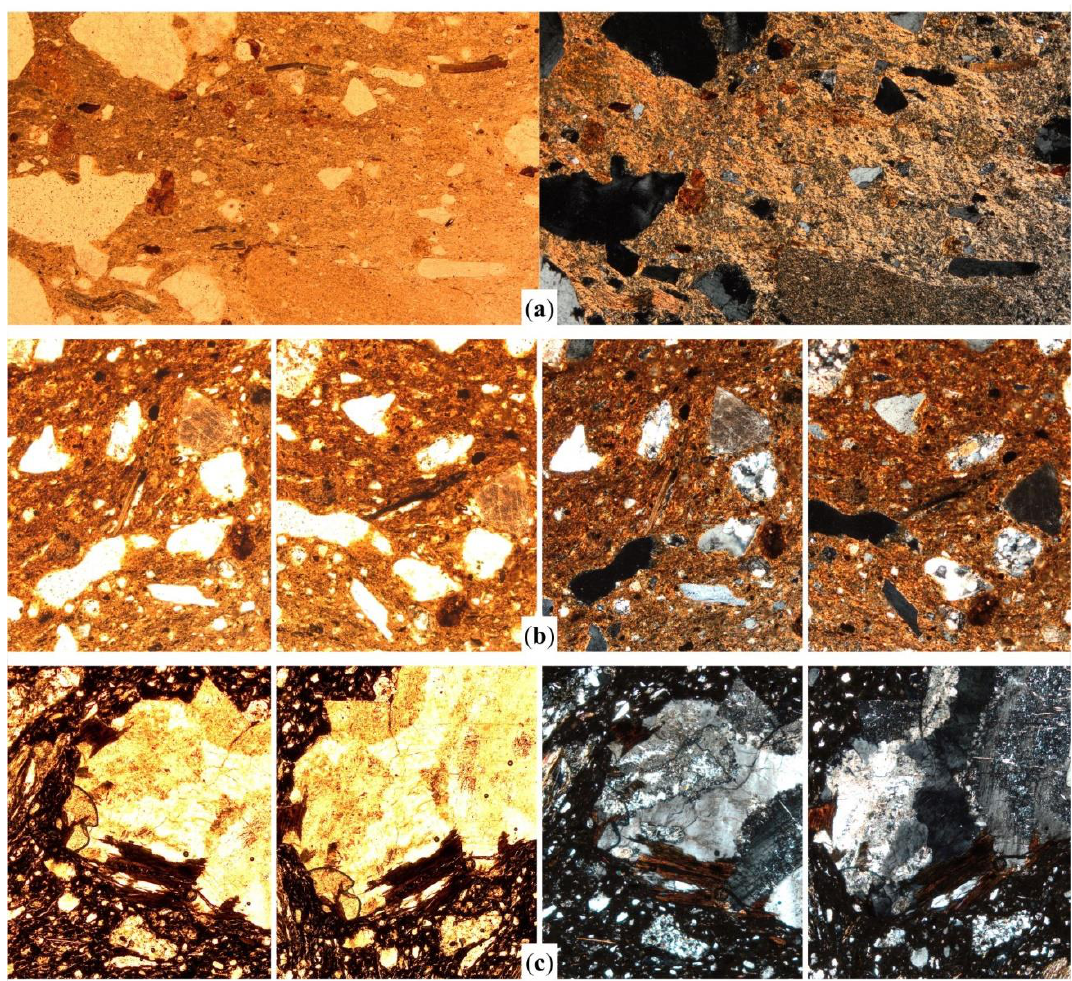
Figure 5. Photomicrographs of specific features of biotite inclusions in some selected samples fired within a range between 800–850 °C. Sample CAU36 shows high to very high pleochroism of biotite related to a moderate birefringence of clay matrix ( a ); samples SFG16 ( b ) and CTM02 ( c ) are shown at different rotation degrees in order to highlight the loss of pleochroism and colour darkening. All the images were captured in plane polarized light (left column) and crossed polars (right column), at 40× magnification. Image width = 3 mm [1.5 mm in (b) and (c)].